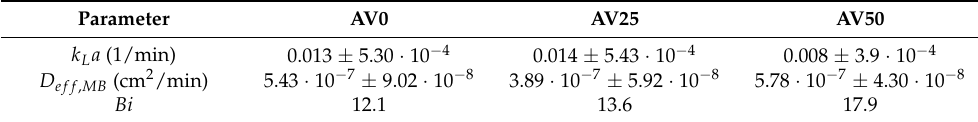
Table 5. Kinetic fitting parameters at 20 ◦ C for AV0, AV25, and